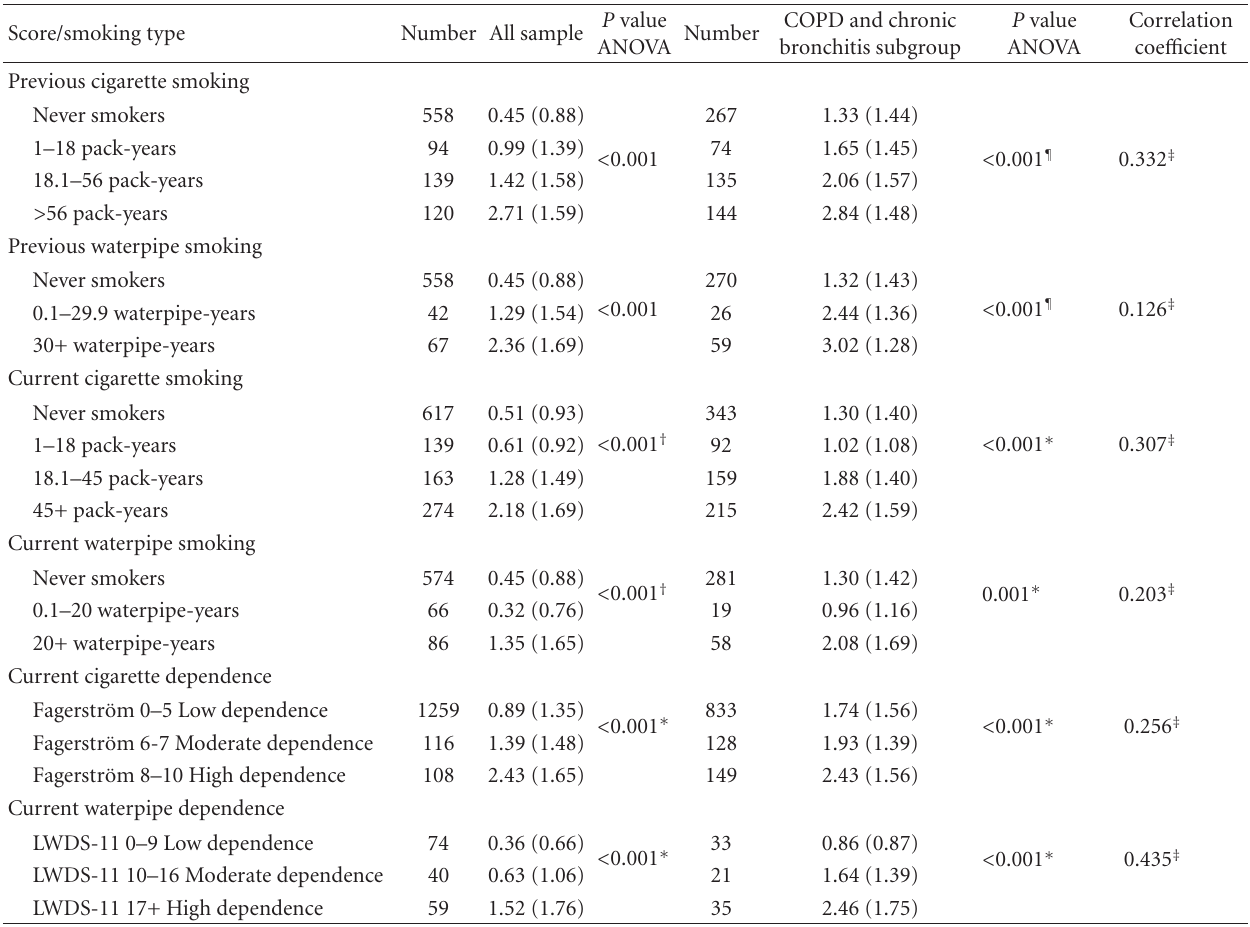
Table 5: Quality of life and smoking doses